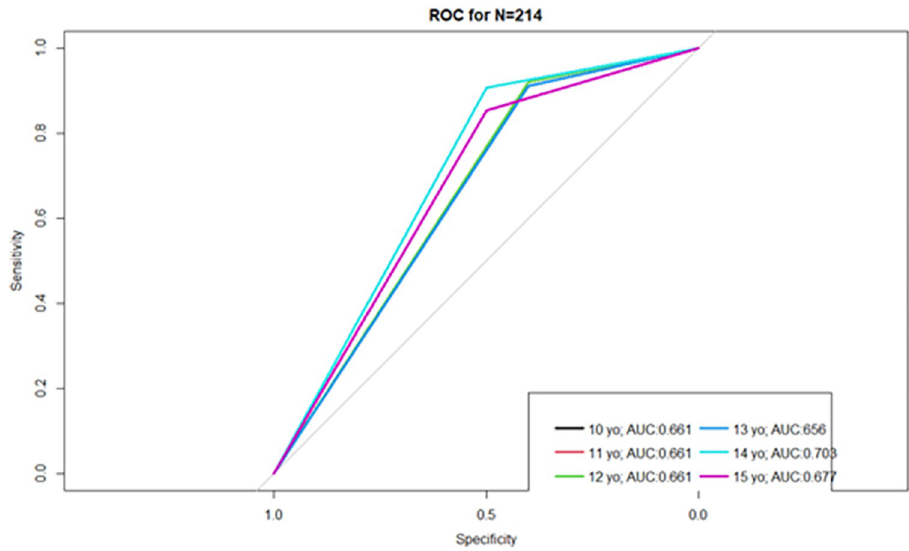
Fig 3. Receiver Operating Characteristic (ROC) curves for the 6 MOHA age cut-offs in the additional young mothers. Receiver Operating Characteristic (ROC) Curves for the 6 MOHA age cut-offs in the additional young mothers with their respective area under the curve (AUC)